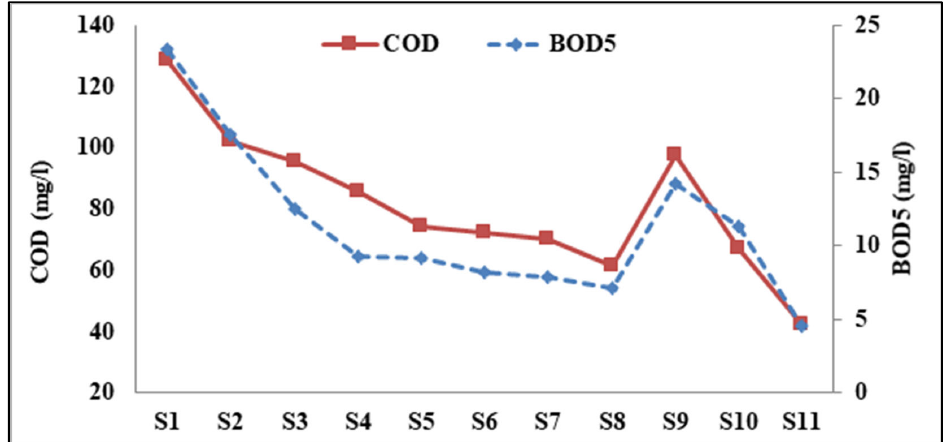
Figure 7. BOD 5 and COD values measured at 11 sampling points in the study area.